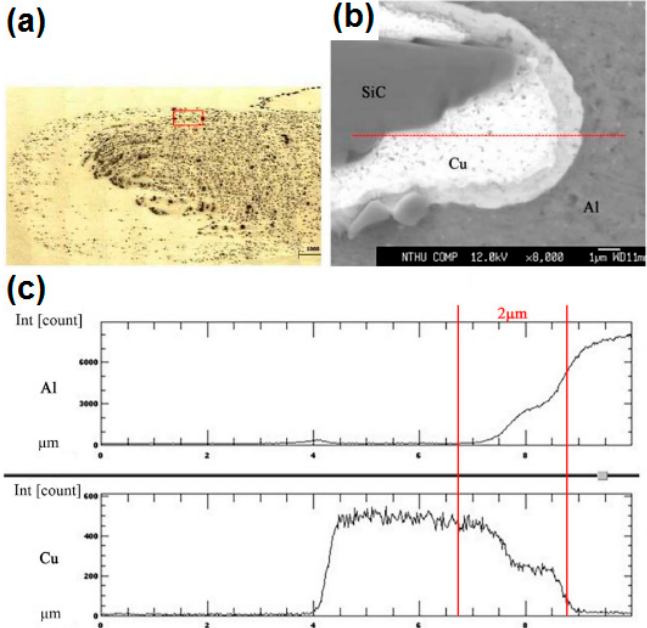
Figure 11. Micrographs of copper-coated SiC particles embedded in the matrix ( a,b ); Al-SiC/Cu reinforcement with EPMA line scan across Cu-coated SiC and Al matrix showing Al and Cu distribution ( c ) (reproduced from [60], with permission from authors, 2018).